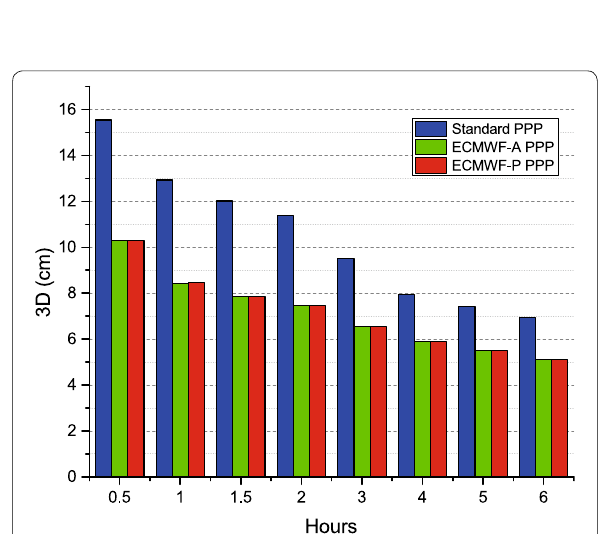
Fig. 3 The 3D RMS values of BeiDou-only PPP results after the processing of different session length (0.5, 1, 1.5, 2, 3, 4, 5, 6 h) from the MGEX stations exhibited in Fig. 1 over a sample period from February 6 to March 8, 2016. Blue denotes the standard PPP solution, green and red represent the ECMWF-augmented PPP solution with analysis and prediction data,